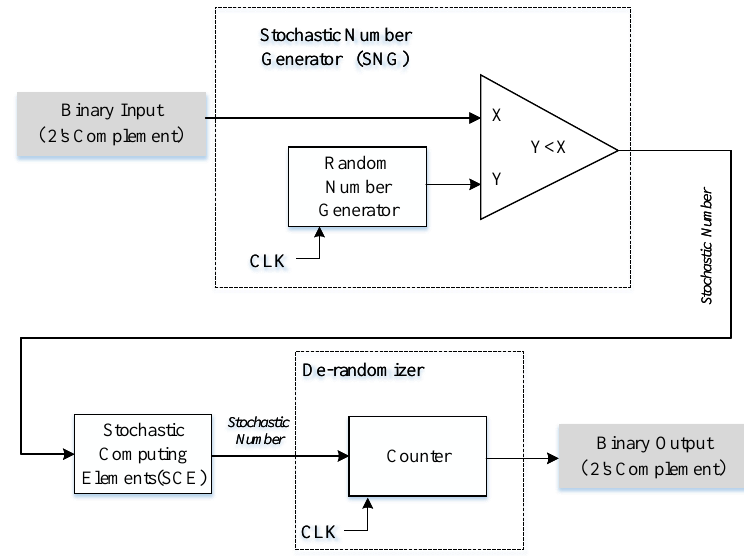
Figure 3. The structure of stochastic